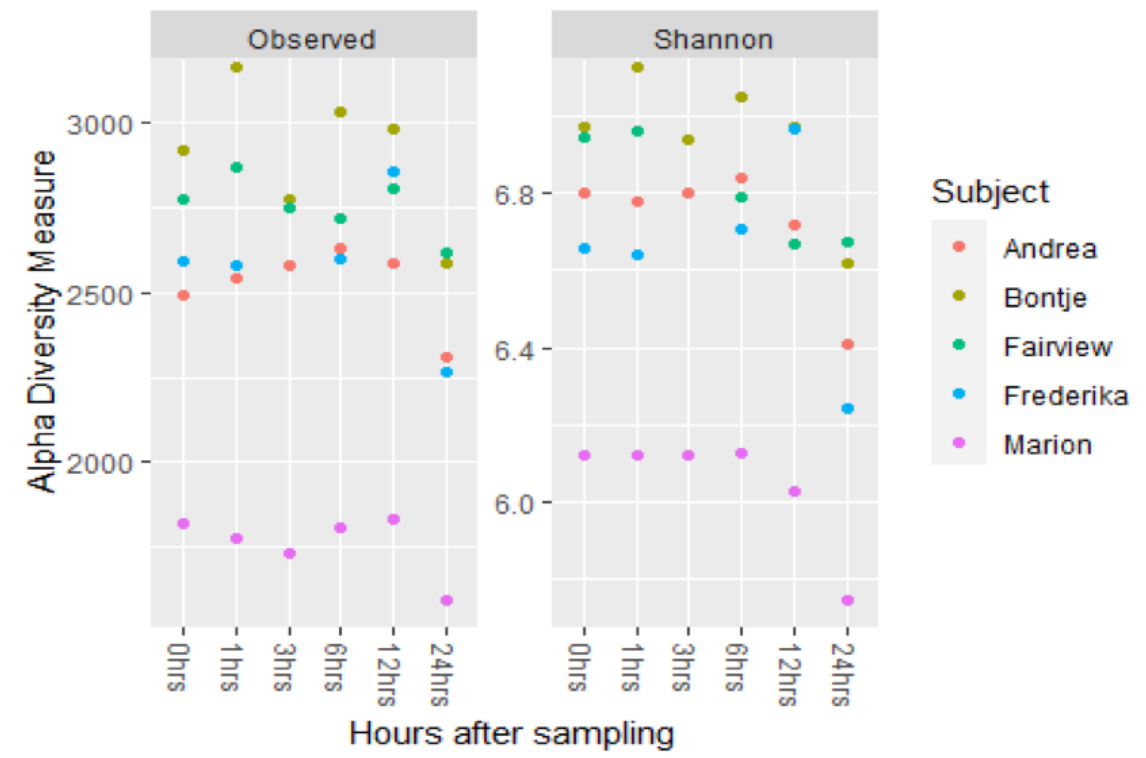
Figure 1. Observed richness and alpha-diversity (Shannon diversity index) of the faecal microbiota over time of faecal samples collected from five ponies after exposure to room air. A decrease in observed richness alpha-diversity is visible after 12 h of air exposure ( p = 0.062).